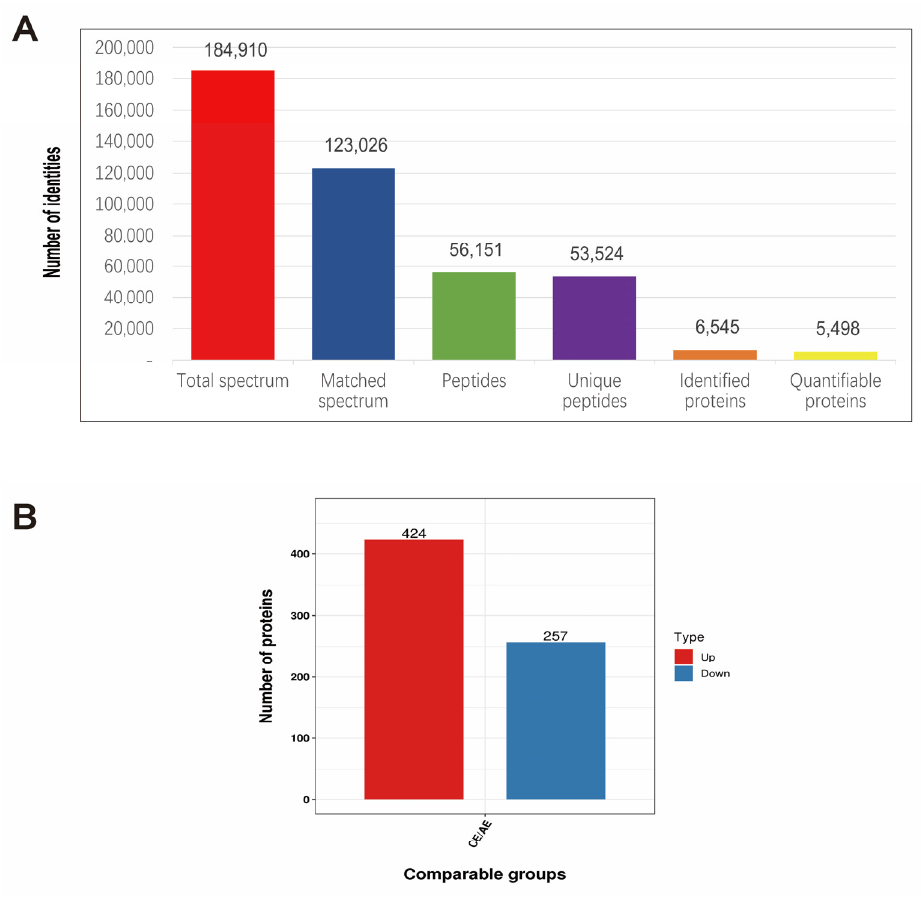
Figure 7. Expression of differentially expressed proteins. ( A ) The basic statistics of mass spectrom- etry data. ( B ) The numerical distribution of differentially expressed proteins in different compari- son groups. Table 1. Differentially expressed proteins of spermidine affecting ovarian function in mice.